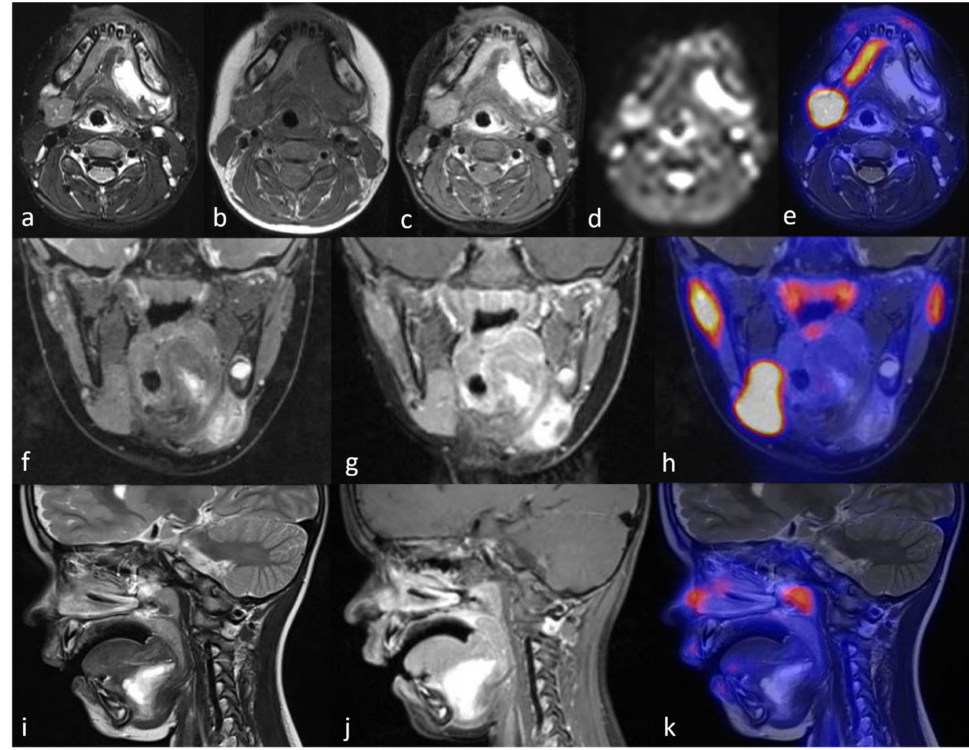
Figure 3. 18 F-PSMA-PET/MRI showing a seroma in the left retro-/submandibular region with hyperintense signal in T2-weighted STIR images ( a , f , i ), isointense signal in T1-weighted images ( b ), peripherally accentuated enhancement after contrast-medium administration ( c , g , j ), no diffusion restriction in diffusion-weighed imaging ( d ), and no 18 F-PSMA uptake in PET ( e , h , k